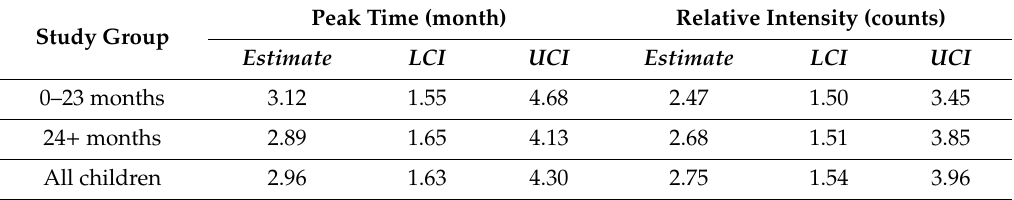
Table 2. The peak timing and intensity values estimated from the regression model.